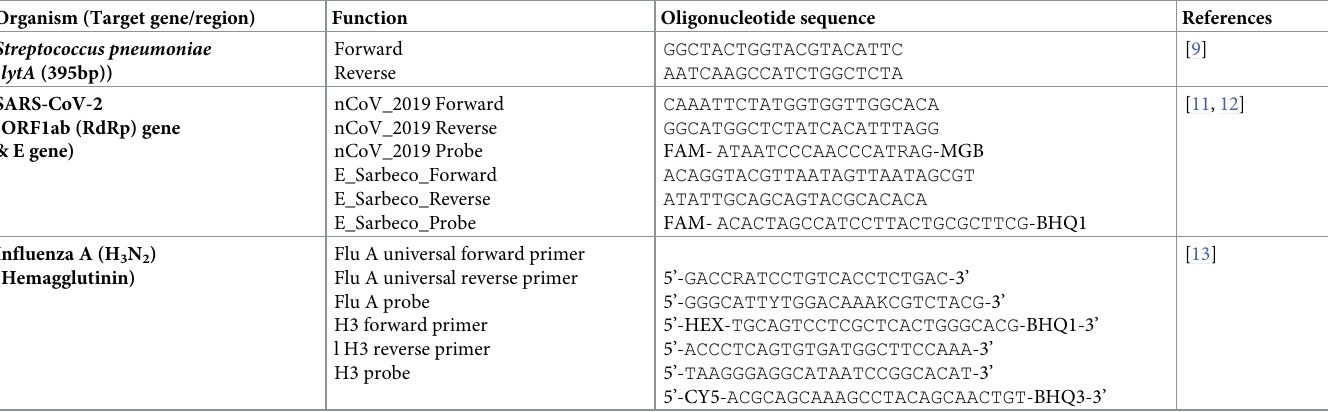
Table 1. Target genes and primer sequences for respiratory